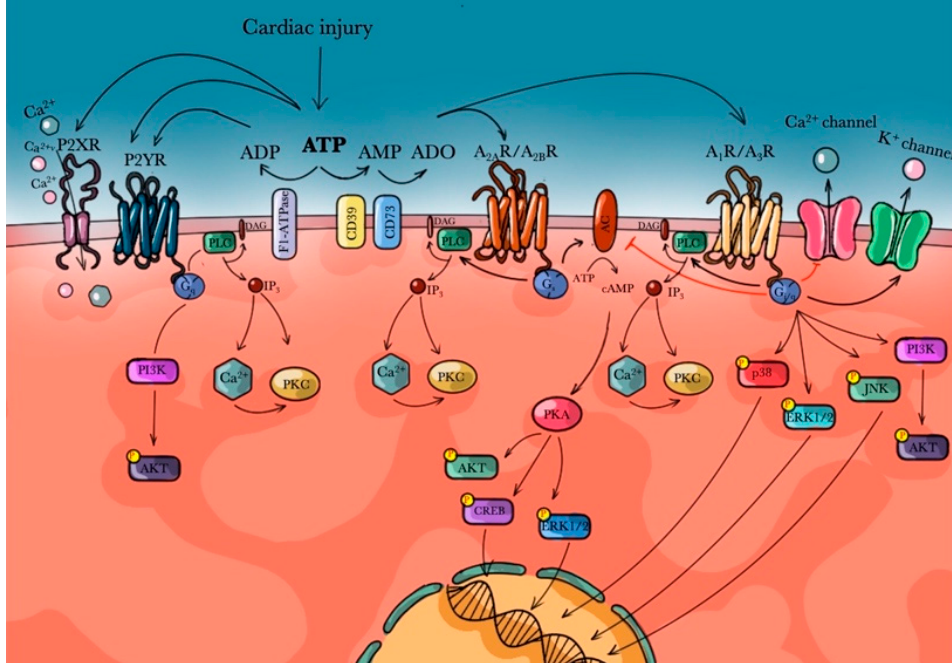
Figure 1. Adenosine receptors role after cardiac injury.